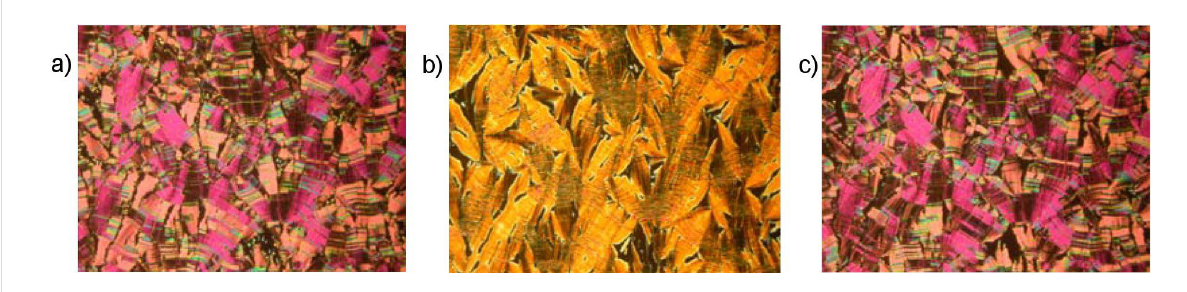
the long molecular axes with respect to the layer normal (Figure 18), from which an effective molecular length of L eff = d /cos θ = 5.0 nm results, which is significantly shorter than the molecular length L calc = 5.5 nm estimated by molecular models. The difference may be caused by a deviation of the molecular configuration from that assumed in the model calculations (e.g., by another bending angle or a high proportion of gauche conformers), or by an interdigitation of the terminal chains (see discussion for OH 4b in Supporting Information File